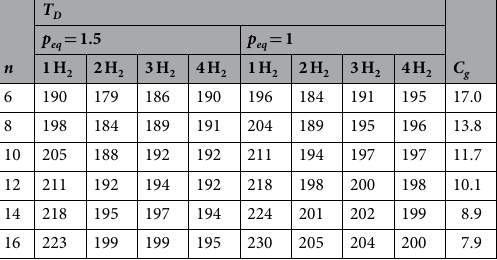
Table 1. Hydrogen desorption temperature T D (K) [calculated using Eq. (9) at p eq = 1.5 (bar) and at p eq = 1 (bar)] and hydrogen gravimetric storage capacity C g (wt%) [calculated using Eq. (10)] for Li 2 B n ( n = 6, 8, … , and 16) with x H 2 molecules ( x = 1–4) adsorbed on each Li, obtained with TAO-BLYP-D. Here, C g is calculated only for x =